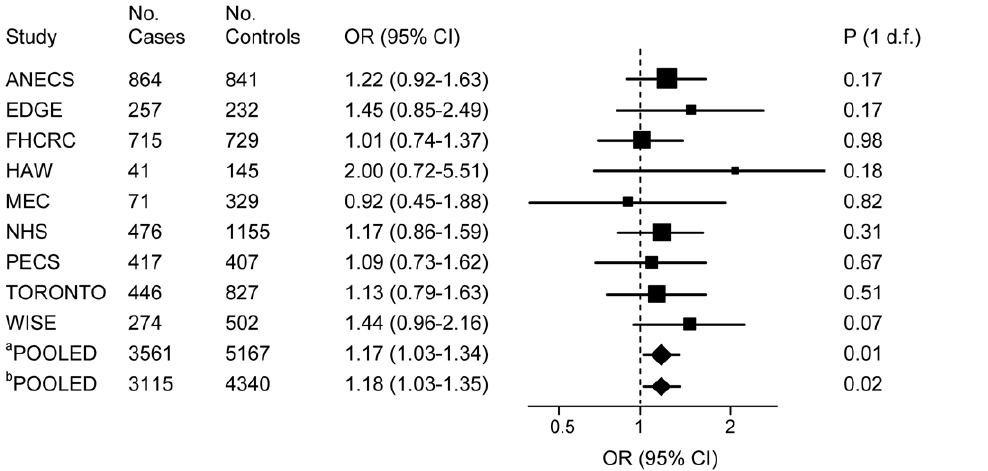
Figure 1. Association of the FTO rs9939609 with endometrial carcinoma risk in non-Hispanic white women. Forest plot of the ORs and 95% CIs comparing endometrial carcinoma risk for the FTO rs9939609 rare allele homozygotes ( AA genotype) versus common allele homozygotes ( TT genotype) for nine studies included in the pooled analysis. The pooled a OR for all studies was 1.17 [95% CI: 1.03–1.34; p (1 d.f.) =0.01.] P for heterogeneity of effects by study=0.87. The pooled b OR for studies including incident cases only (excluding TORONTO study) was 1.18 [95% CI: 1.03– 1.35; p (1 d.f.) =0.02]. P for heterogeneity of effects between studies with incident cases vs. prevalent cases (TORONTO) =0.78. Pooling was performed by combining all data using study as fixed and random effects (results were the same).